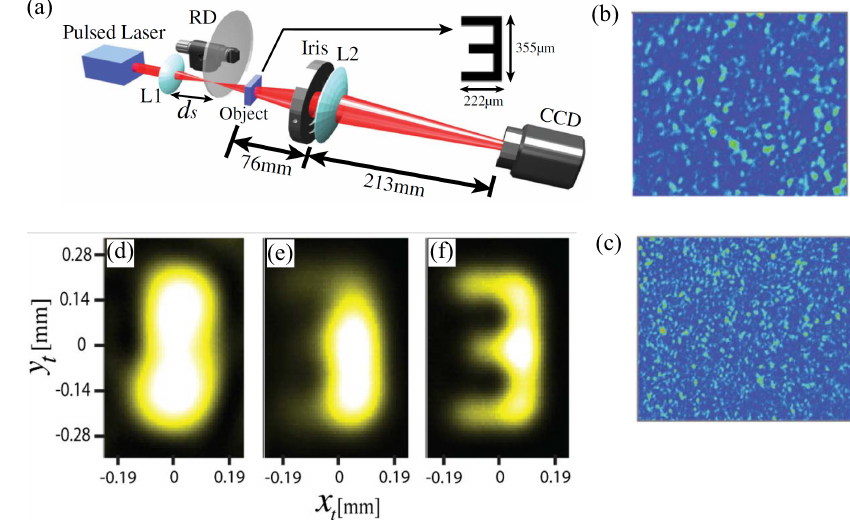
Figure 4. Super-resolution imaging with pseudothermal light illumination. ( a ) represents the schematic of experimental setup with the pseudothermal light generated by launching a focused laser beam onto a rotating ground glass disk (RD). The spatial correlation length of the illumination pseudothermal source is controlled by varying the distance ( d s ) between the lens L 1 and the RD, which is revealed by the instantaneous intensity image of the illumination speckle field on the object plane ( b , c ). Compared to the conventional intensity image ( d ), second-order correlation measurement leads to super-resolution image of the object, such as that shown in ( e ) with speckle illumination ( b ), and ( f ) with speckle illumination ( c ). The figure is reproduced with permissions from Ref. [34] of